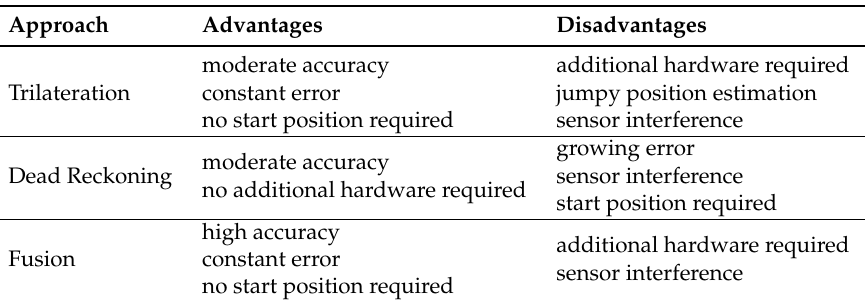
Table 21. Summary of the obtained